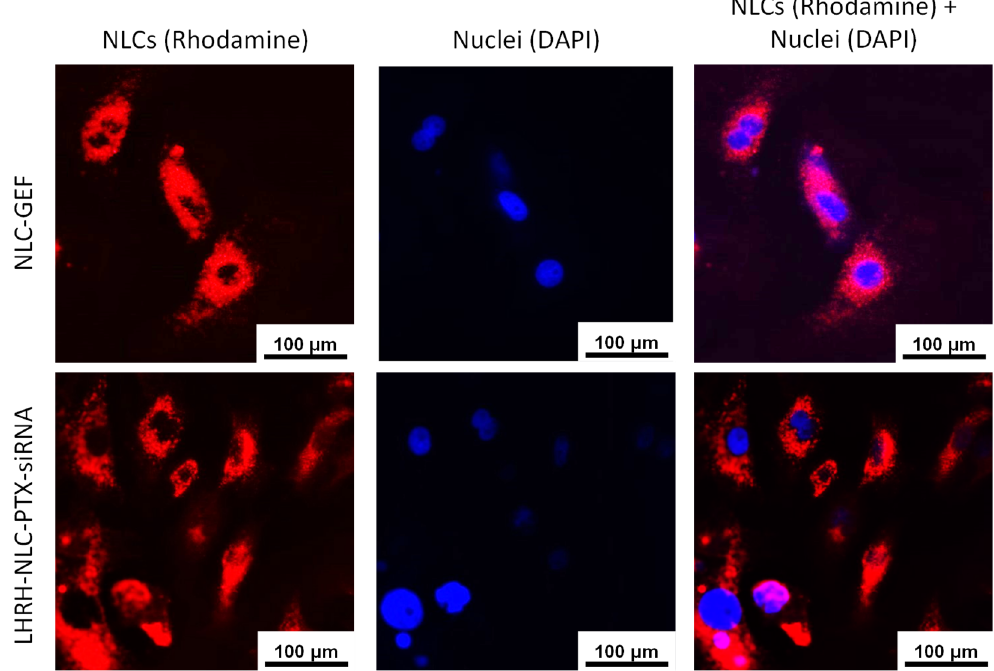
Figure 7. Representative fluorescence images of human NSCLC A549 cells incubated with rhodamine-labeled NLCs containing drugs and siRNA.